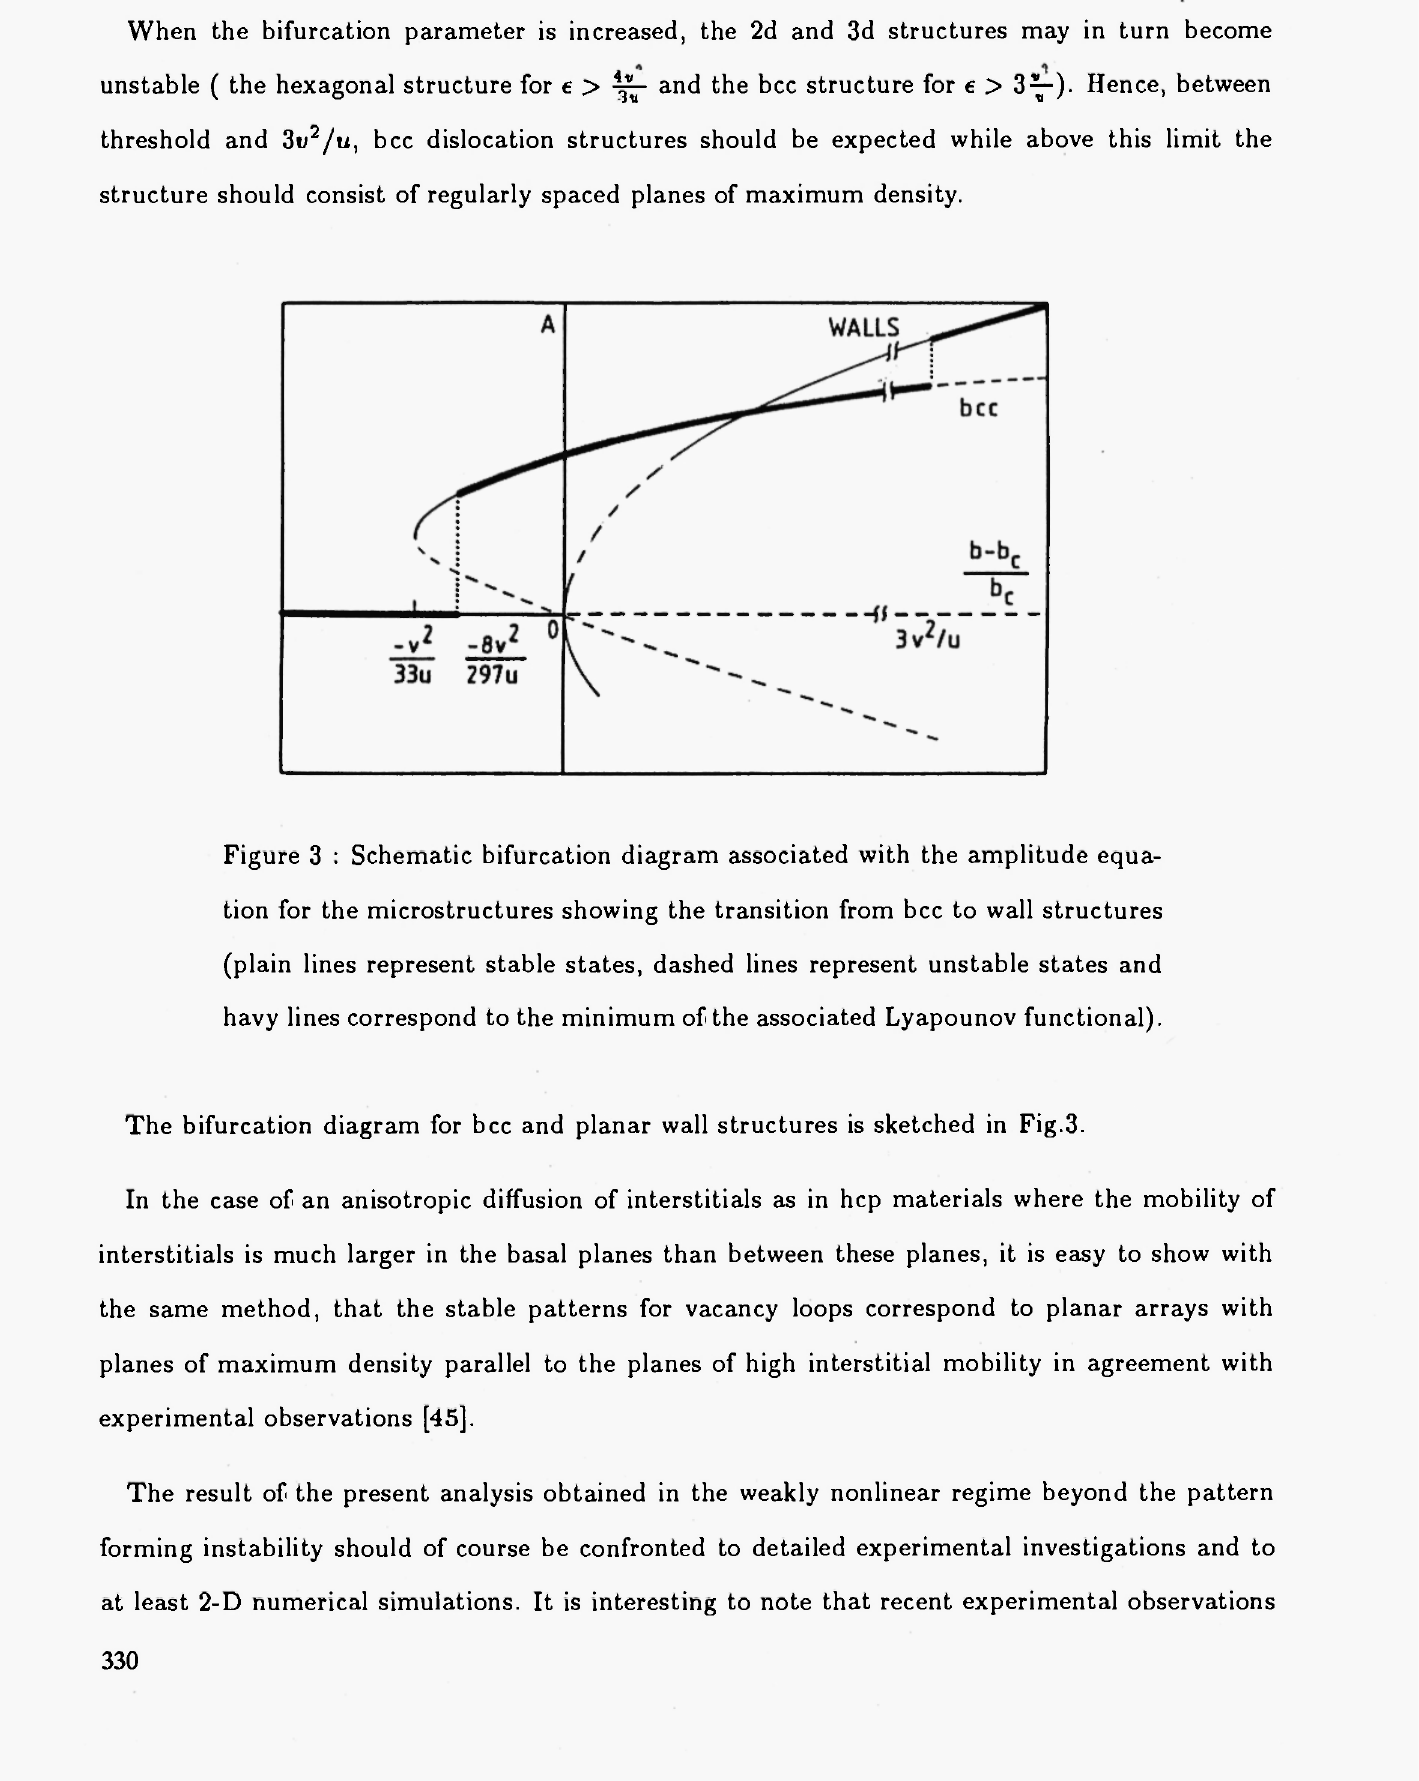
Figure 3 : Schematic bifurcation diagram associated with the amplitude equa- tion for the microstructures showing the transition from bcc to wall structures (plain lines represent stable states, dashed lines represent unstable states and havy lines correspond to the minimum of the associated Lyapounov